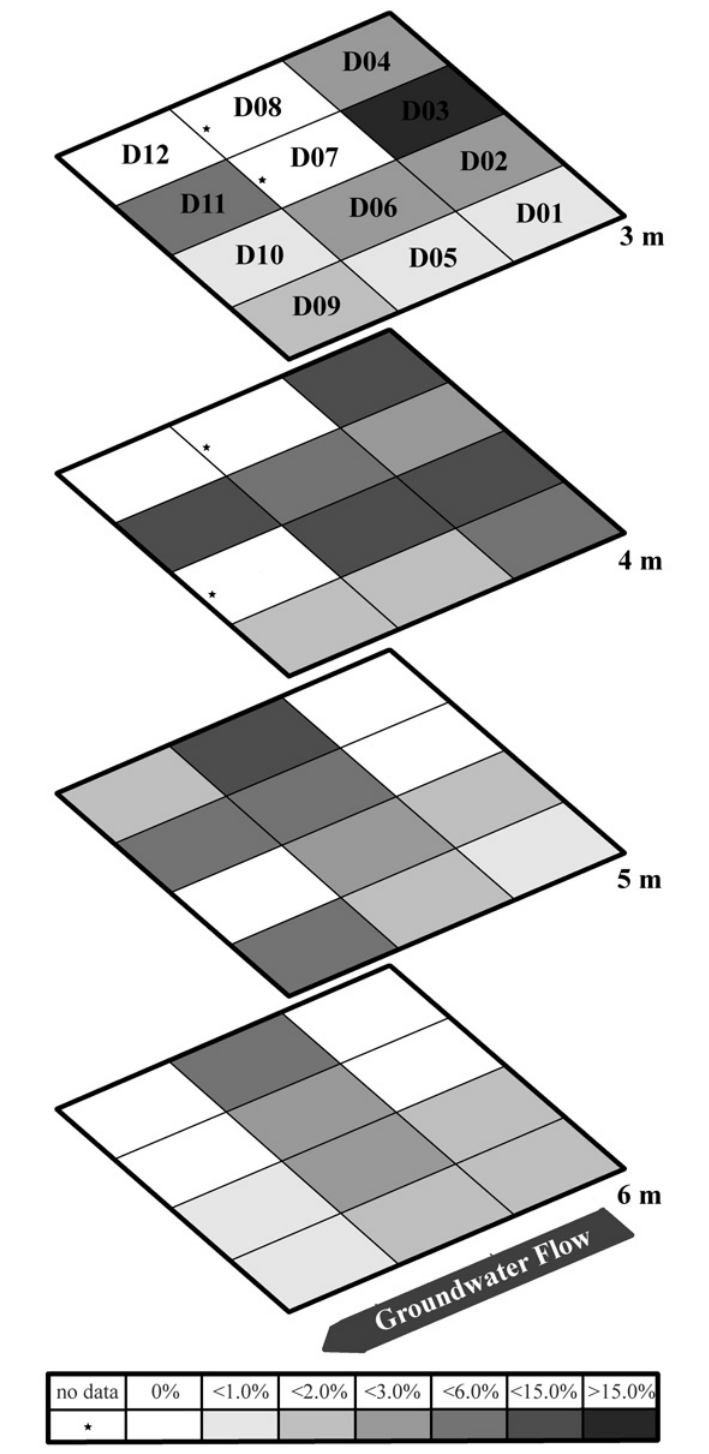
Fig 5. Spatial distribution of Burkholderia fungorum strain Rifle based on percent contribution to overall microbial community using the 166 bp MnlI peak in the bacterial TRFLP profile.